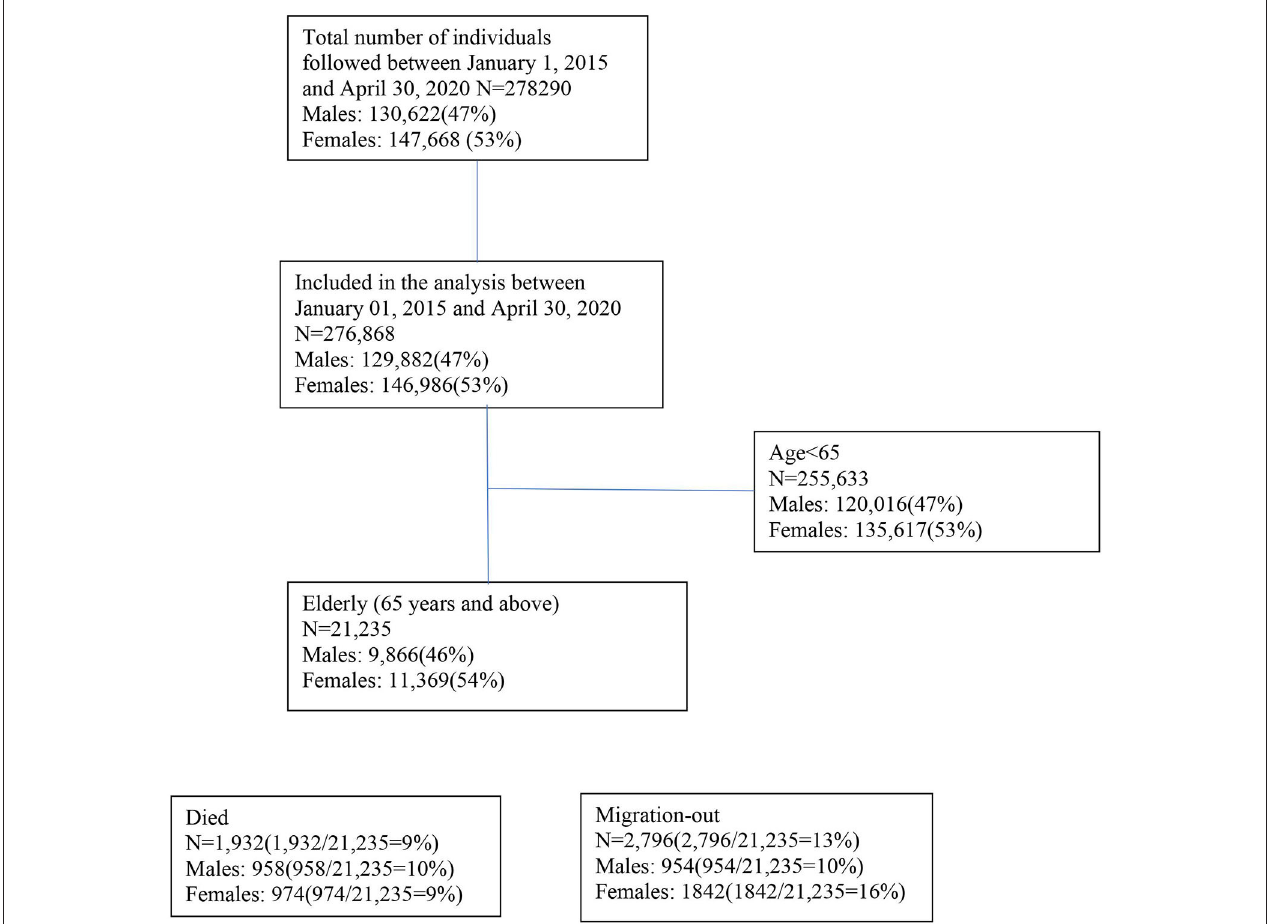
FIGURE 1 | Flowchart of the study population.